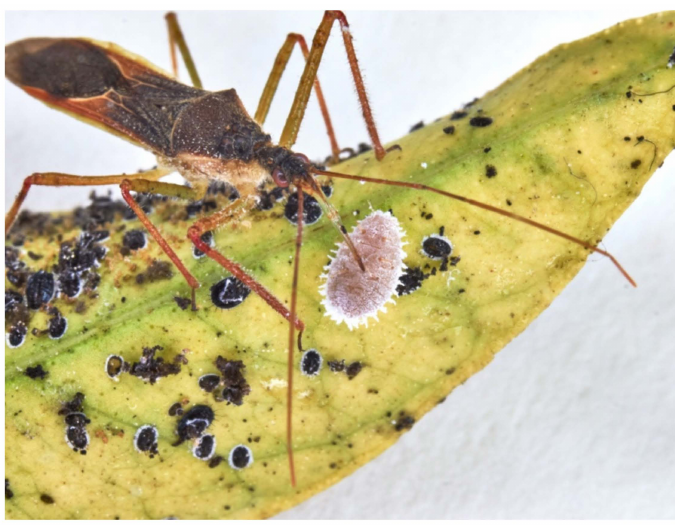
Figure 10. LAB female feeding on Planococcus citri